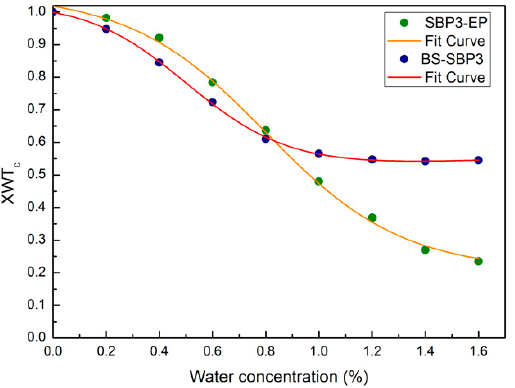
Figure 8. XWTC behavior as a function of water content concentration for the intramolecular OH- stretching bands for BS-SBP3 (blue circles) and EPS-SBP3 (green circles); fitting curves for BS-SBP3 and EPS-SBP3 are shown in red and orange, respectively.